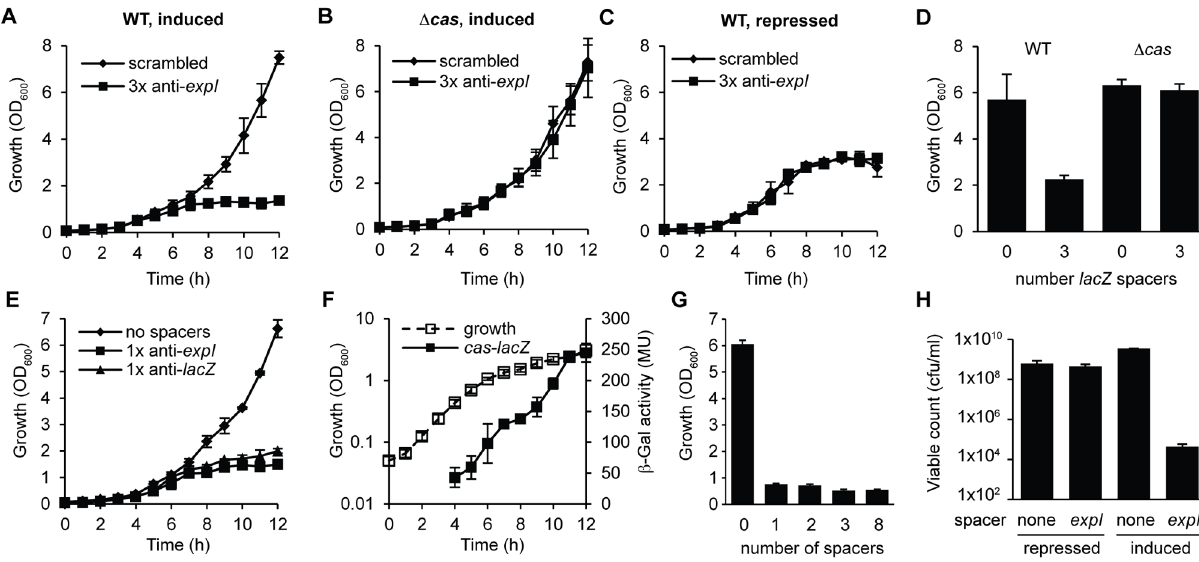
Figure 2. Controlled expression of single anti- expI or anti- lacZ spacers causes cas –dependent growth inhibition and a reduction in viable count. Plasmids containing either 3 scrambled spacers (pS3-16) or 3 spacers targeting expI (pE3-16) were induced in either (A) WT or (B) D cas (PCF80) strains or (C) repressed in the WT. (D) Plasmids containing either no spacers (pC1-16) or 3 spacers targeting lacZ (pL3-16) were induced in either WT or D cas strains and measured after 12 h. (E) Plasmids containing no spacers (pC1-16) or one spacer targeting expI (pE1-16) or lacZ (pL1-16) were induced in the WT. (F) Expression of the cas operon measured from a chromosomal transcriptional/translational lacZ fusion (PCF79). (G) Plasmids containing no spacers (pC1-16) or one, two, three or eight identical spacers (pTraG1-16, pTraG2-16, pTraG3-16 and pTraG8-16) display similar toxicity. (H) Viable count (cfu/ml) after 12 h with either repression or induction of plasmids encoding no spacers (none) or 1 6 anti- expI ( expI ). Limit of detection was 1 6 10 2 . Data shown are the mean 6 the SD of three